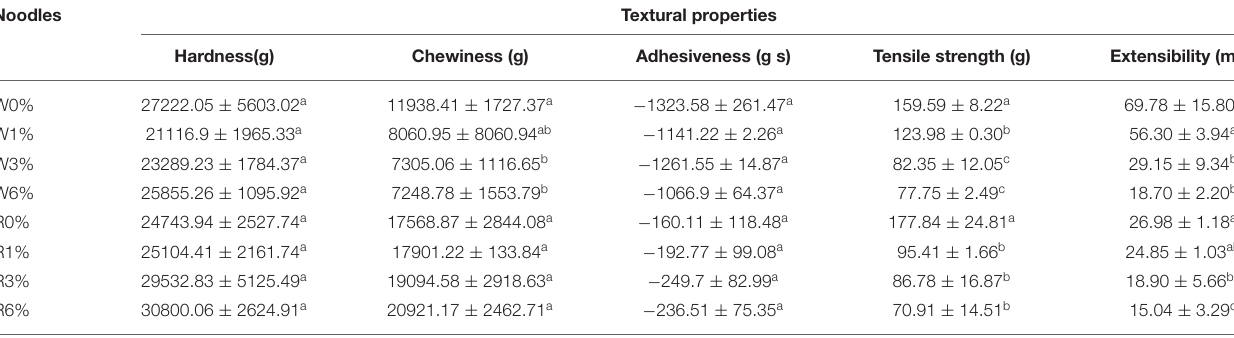
TABLE 4 | Textural properties of cooked noodles incorporated with EA extracts.